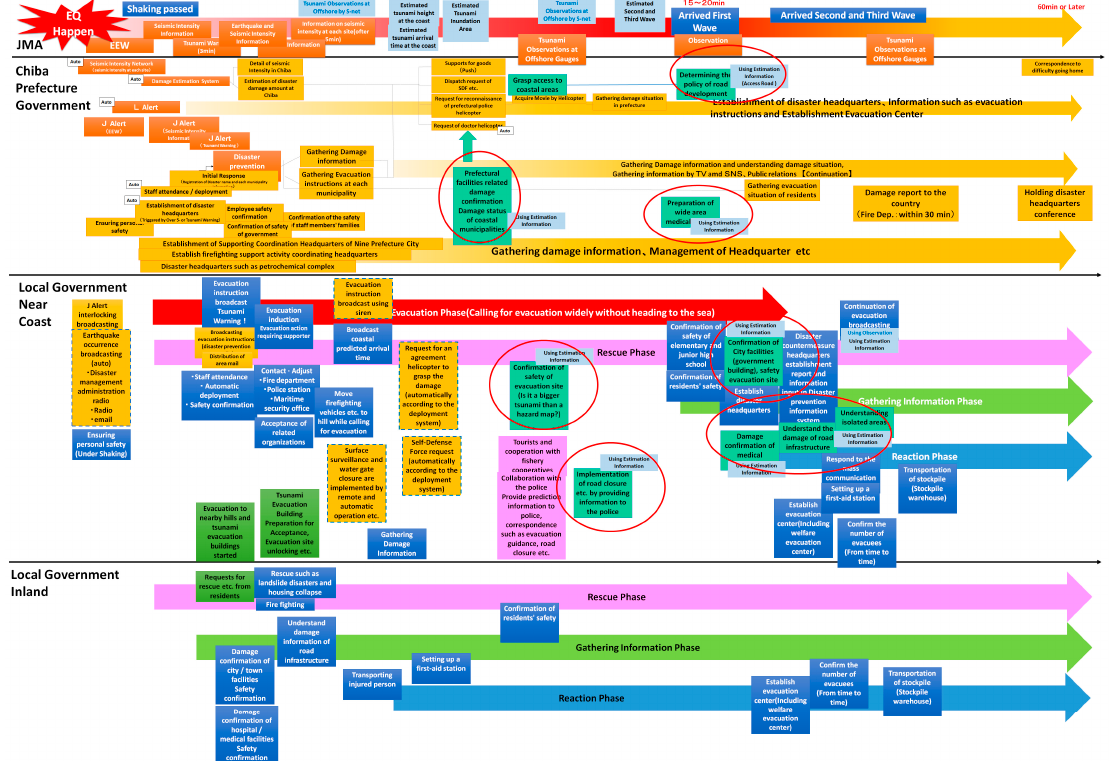
Figure 11. SOP that we developed based on the results of this AAR and the lessons from the 2011 Great East Japan Earthquake for the users of the Real-Time Tsunami Inundation Forecast System. The red circles are the action cards of the tsunami disaster response using the Real-Time Tsunami Inundation Forecast System for local government